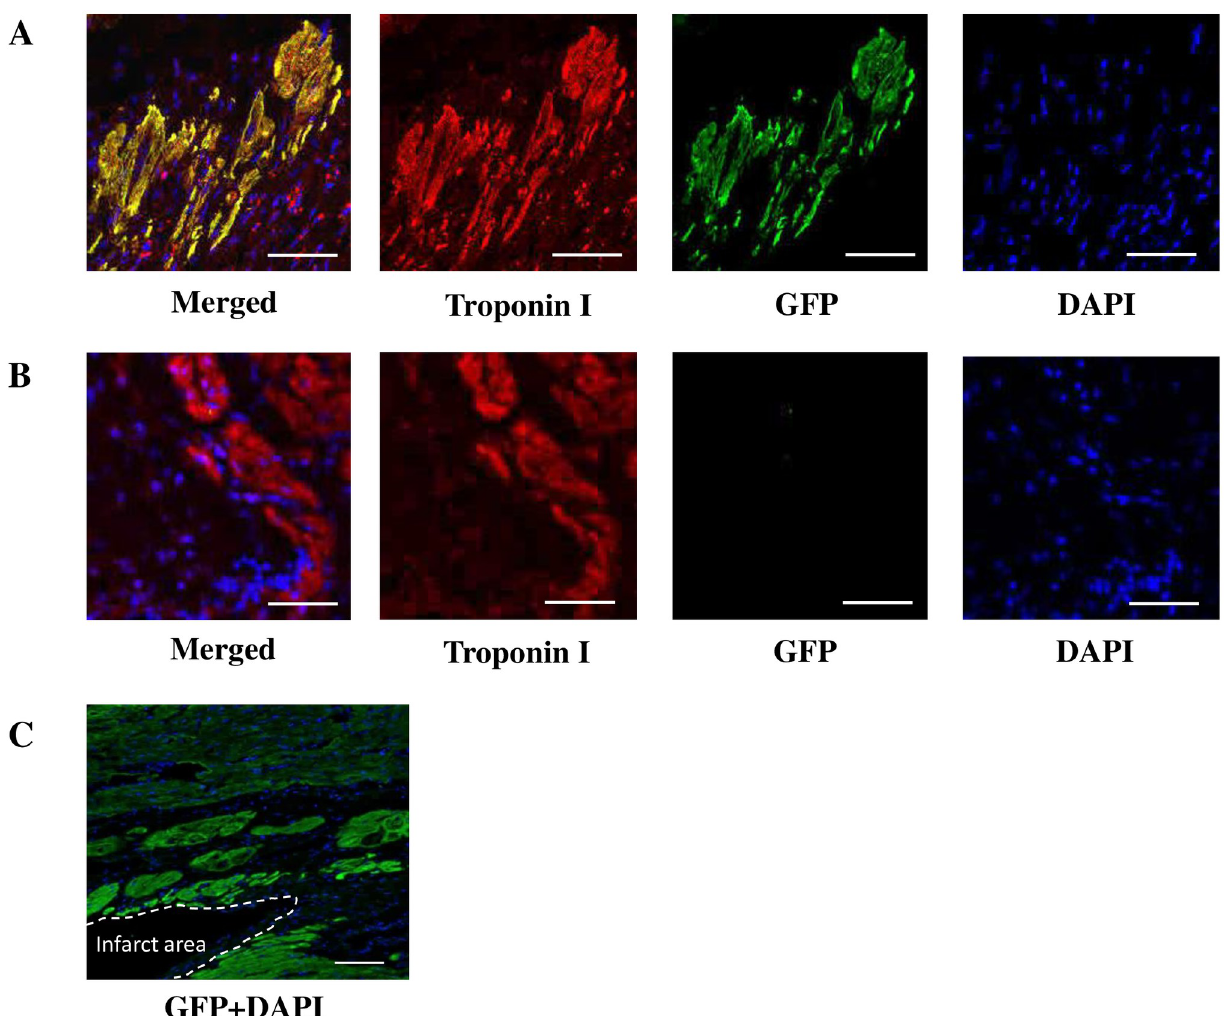
Fig 2. Differentiation of Muse cells into cardiomyocytes. A: GFP-labelled Muse cells and cardiac troponin I in the infarct border area. GFP (green) and troponin I (Red) are merged, suggesting that GFP-labelled Muse cells differentiated into cardiomyocytes. Bar = 50 μ m. B: Negative control in the infarct border area. Troponin I positive cells (red), DAPI (blue), Bar = 50 μ m. C: GFP (green)-labelled Muse cells are engrafted in the infarct border area. Bar = 100 μ m.